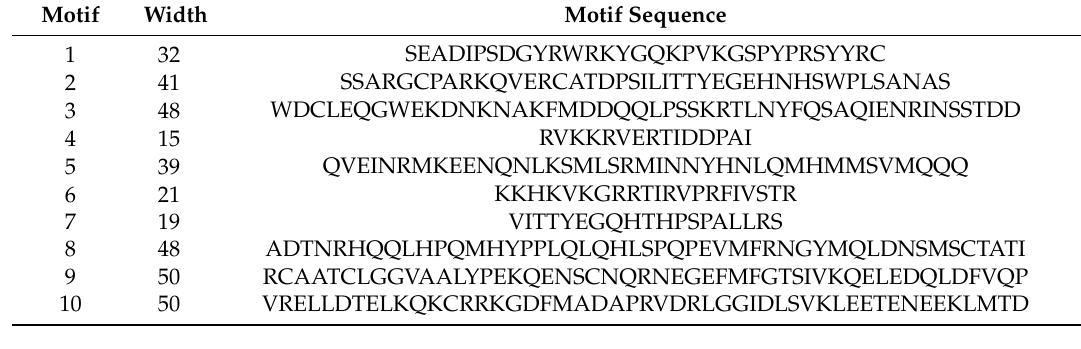
Table 3. Details of conserved motifs from PmWRKY proteins.